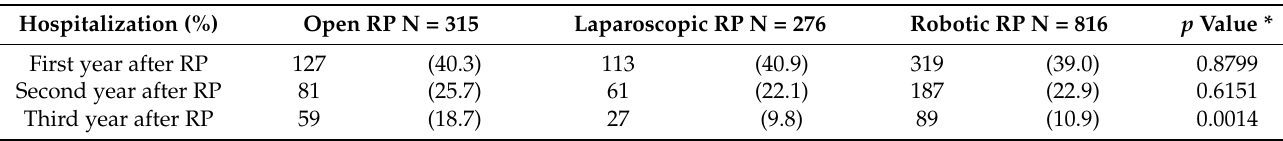
Table 3. Generalized linear mixed model of hospitalization for urinary diseases or surgical complications stratified by open, laparoscopic, and robotic RP.